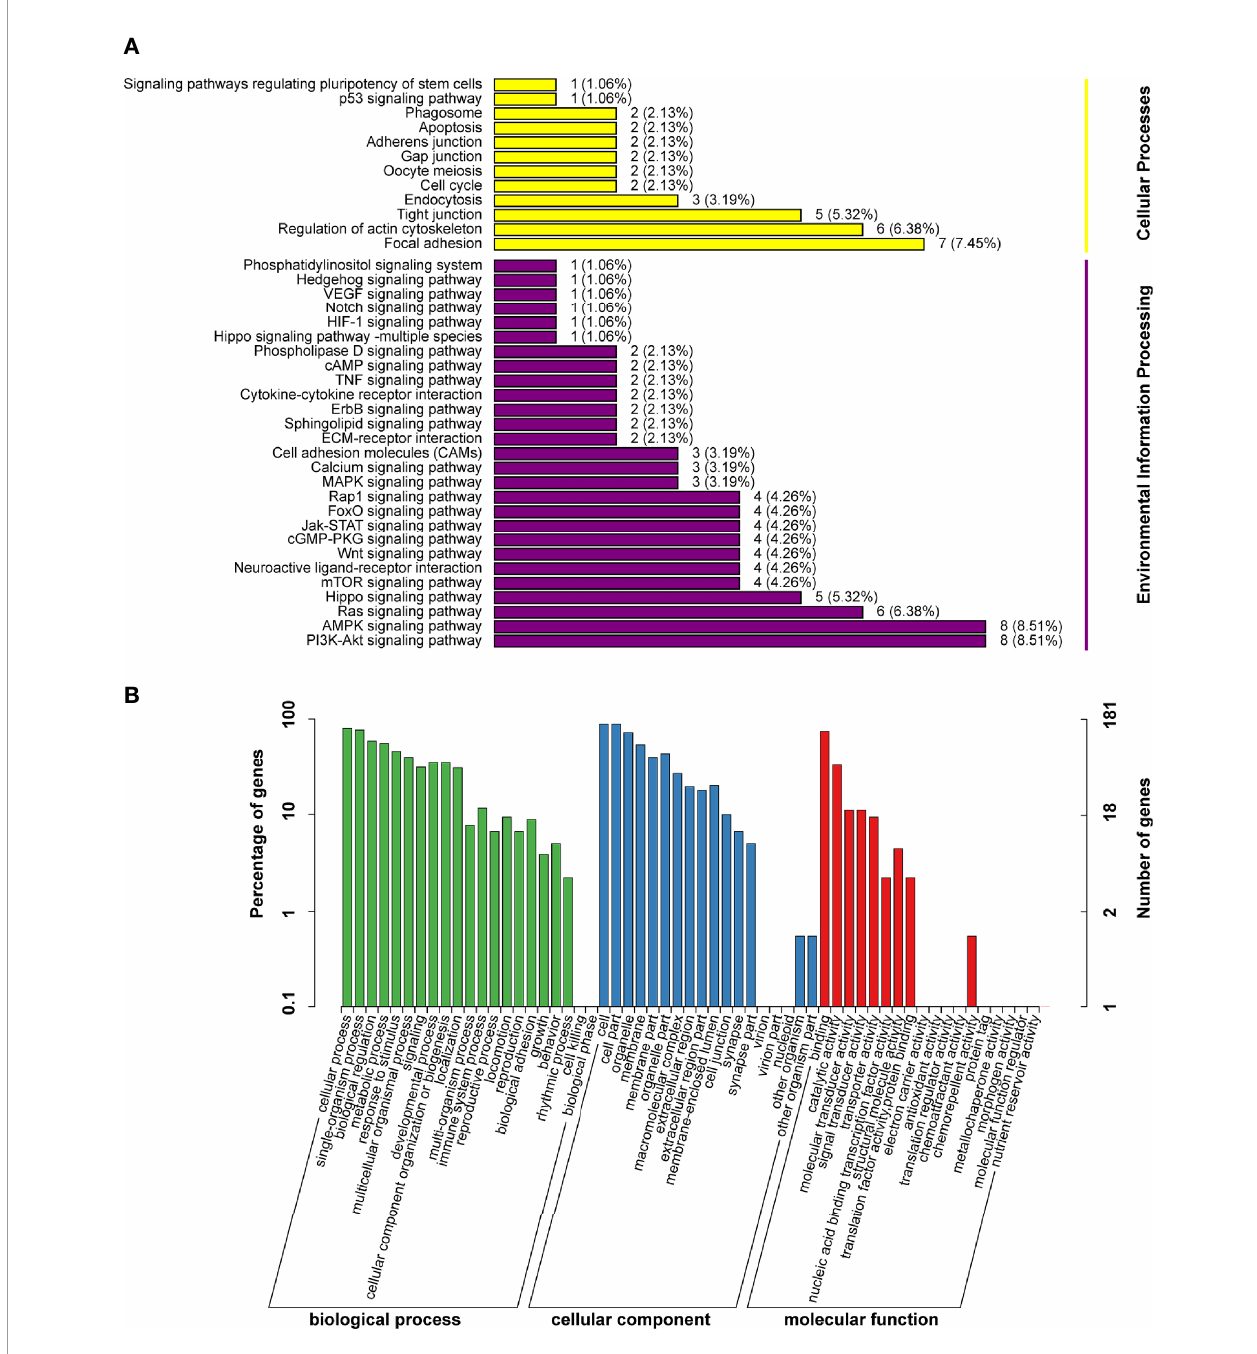
FIGURE 6 | The analysis of DEGs between db/db mice and Sal-treated db/db mice. (A) The DEGs between db/db mice and Sal-treated db/db mice were analysed by KEGG databases. (B) The DEGs between db/db mice and Sal-treated db/db mice were analysed by GO